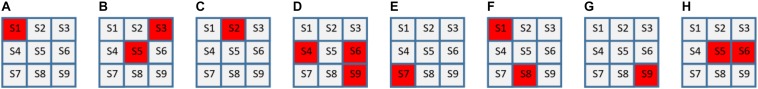
Randomly touching one (A,C,E,G), two (B,F,H), or three FSR sensors (D) from the 3 × 3 grid in the experimental setup shown in Figure 8. The activated sensors are shown by the red boxes. Different amounts of forces with dissimilar time profiles are applied to the FSR sensors. (A) to (H) show the sequence of touched sensors in eight stages, respectively.